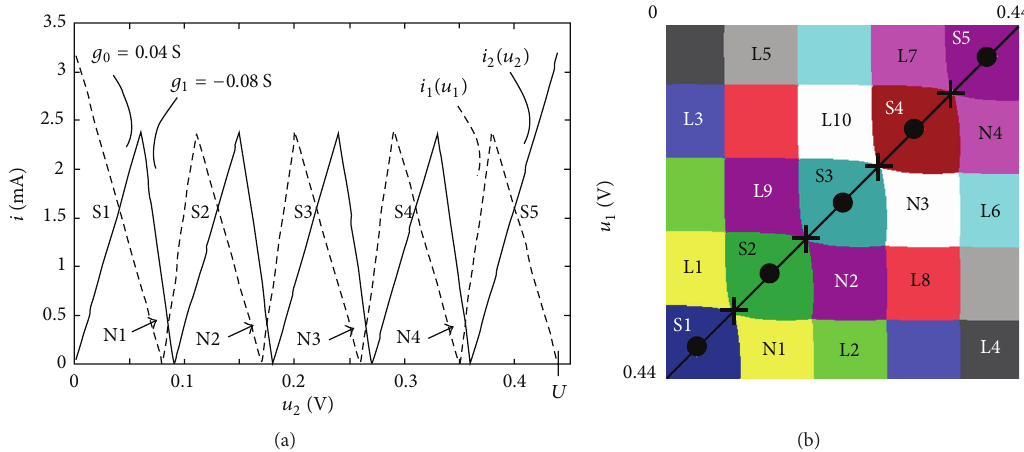
Figure 4: (a) Projection of the I-V characteristics and depiction of the singular points into the plane 𝑖 , 𝑢 2 for 𝑅 = 0Ω . Cross-sections of the BS in the plane 𝑢 2 , 𝑢 1 ; (b) N 1 –N 4 𝑖 = 0.4 mA. Values of the parasitic elements considered in all simulations are 𝐿 = 1 ⋅ 10 −10 H and = 𝐶 = 2.6 ⋅ 10 −13 F. 𝐶 1 2